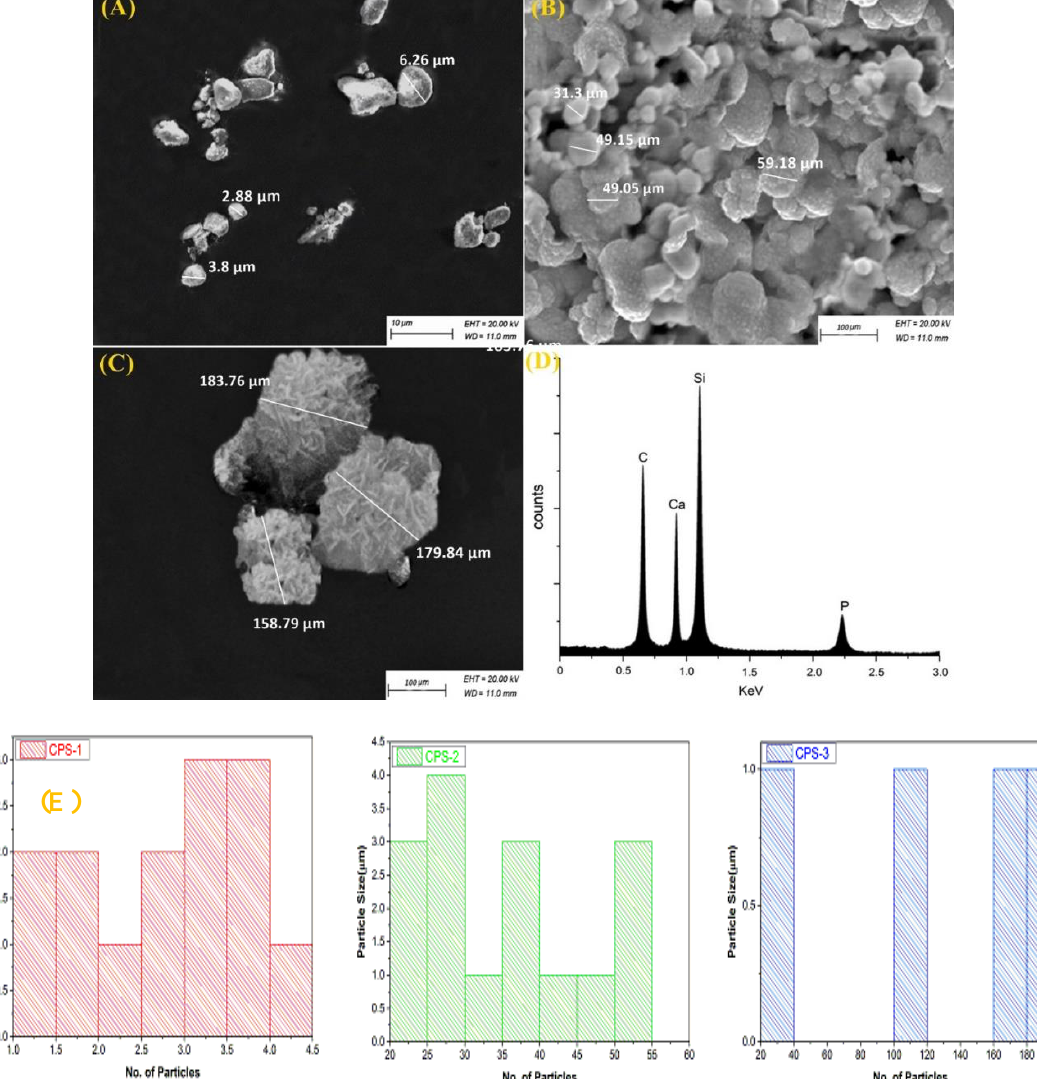
Figure 4. Typical SEM analysis of CPS-1 ( A ), CPS-2 ( B ), CPS-3 ( C ), energy dispersive spectroscopy (EDS) spectrum of CPS-3 ( D ) and particle size distribution histogram for CPS-1, CPS-2, CPS-3 ( E ).